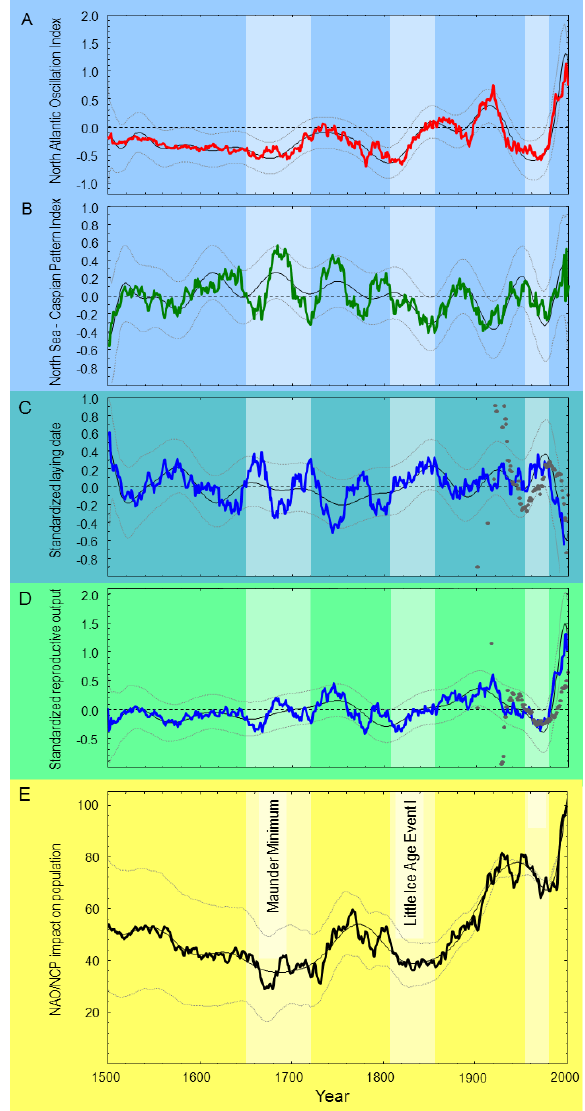
Fig. 4. The decadal fluctuation in the North Atlantic Oscillation Index NAOI and the North Sea – Caspian Pattern Index NCPI and their effect on key parameters of the great tit population in Switzerland since 1500AD. Bold lines give 25-yr moving averages (windows declining to 11yr at end points). Fine solid lines and dotted lines give the fit and 90% confidence bands to annual values by 10 × 2 Fourier series polynomial re- gression. (a) NAOI reconstruction (Luterbacher et al., 2001). (b) NCPI reconstruction (Kutiel and Benaroch, 2002, own data). Note the different scale in the y-axes in (a) and (b) . (c) Standardized residual laying date as modelled from NAOI/NCPI reconstruc- tions and the structural equation model given in Fig. 2. Grey dots give 25-yr moving averagesofobservedstandardizedresiduallayingdates1901–1999(intervalsdeclining to 5-yr averages at end points, raw annual observations are given before 1930) (d) stan- dardized residual number of fledglings as modelled from NAOI/NCPI reconstructions and the structural equation model given in Fig. 2. Grey dots give 25-yr moving aver- ages of observed standardized residual number of fledglings 1901–1999 (intervals de- clining to 5-yr averages at end points, raw annual observations are given before 1930). (e) Component effect of reconstructed NAOI and NCPI on the population fluctuations, expressed as an index set to 100 points in year 2000. The three minima in the popula- tion index coincide with periods in which climatic conditions in central Europe were harsh: the Maunder Minimum (1650–1720), the Little Ice Age Type Event I (1810– 1850; Wanner et al., 2001), and 1950–1975. Dotted lines give ± 2 s.e. bands of relative population index (double smoothing applied).